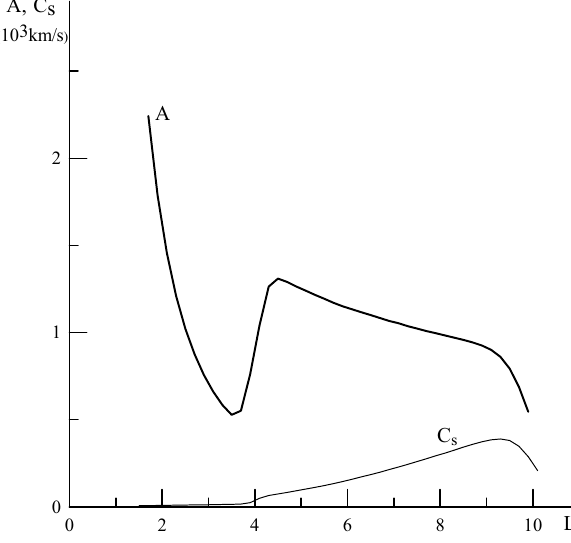
Fig. 2. Equatorial distribution of the Alfv´en velocity A and the velocity of SMS waves C S across the magnetic shells ( L = a/R E , R E is the Earth’s